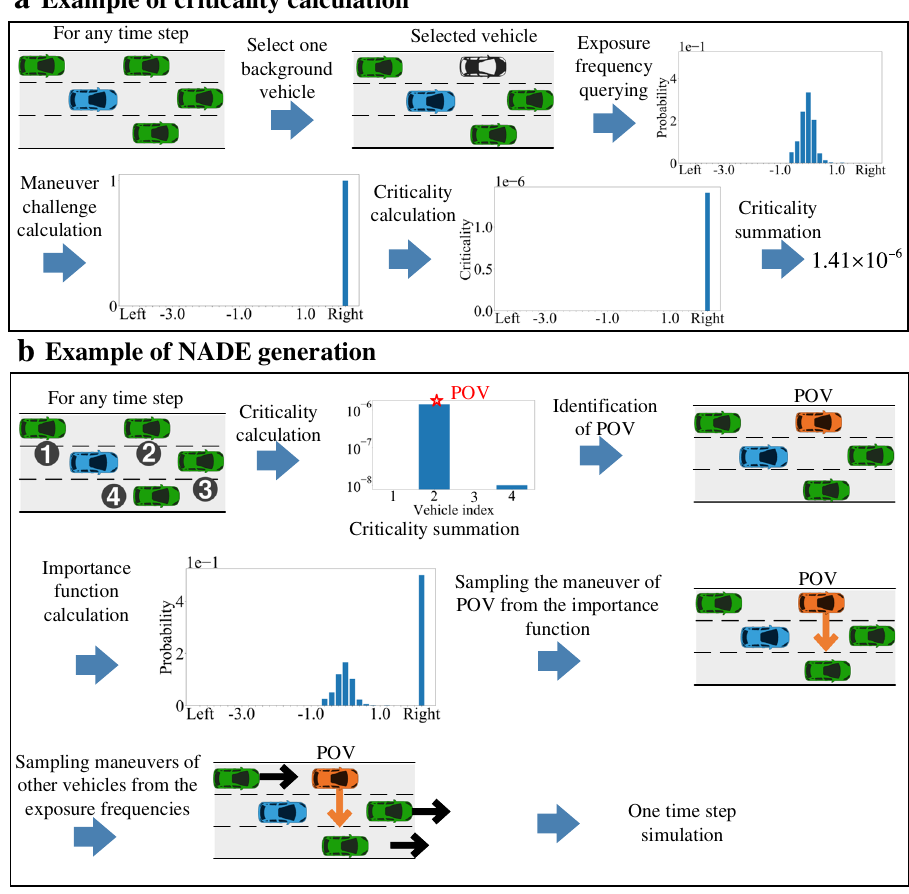
Fig. 5 Illustration of NADE generation. a Example of criticality calculation. For each background vehicle (green vehicle) at each time step, the criticality of each maneuver is calculated by the multiplication of exposure frequency and maneuver challenge. The blue vehicle denotes the autonomous vehicle. b Example of the naturalistic and adversarial driving environment (NADE) generation. For each time step, the criticality summations of all background vehicles are calculated for the identi fi cation of the principal other vehicle (POV, orange vehicle). If the POV exists, the importance function is calculated, and the maneuver of the POV is sampled from the importance function, while others follow their naturalistic distributions. The image of vehicles